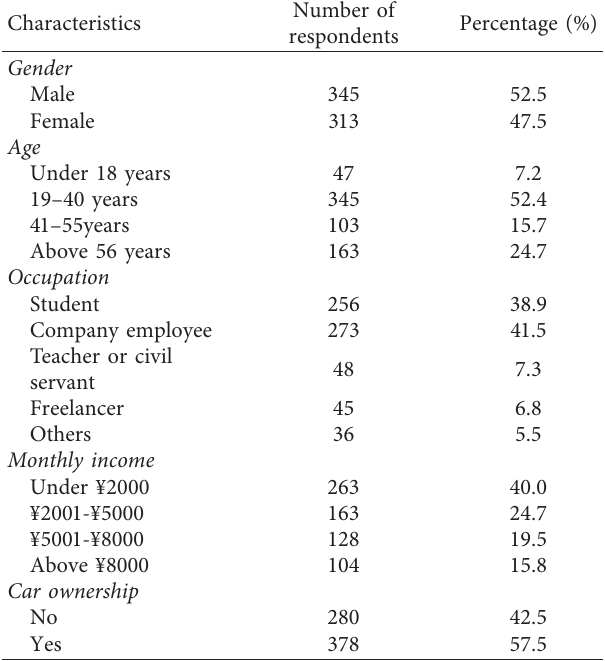
Table 3: Sociodemographic characteristics of the survey